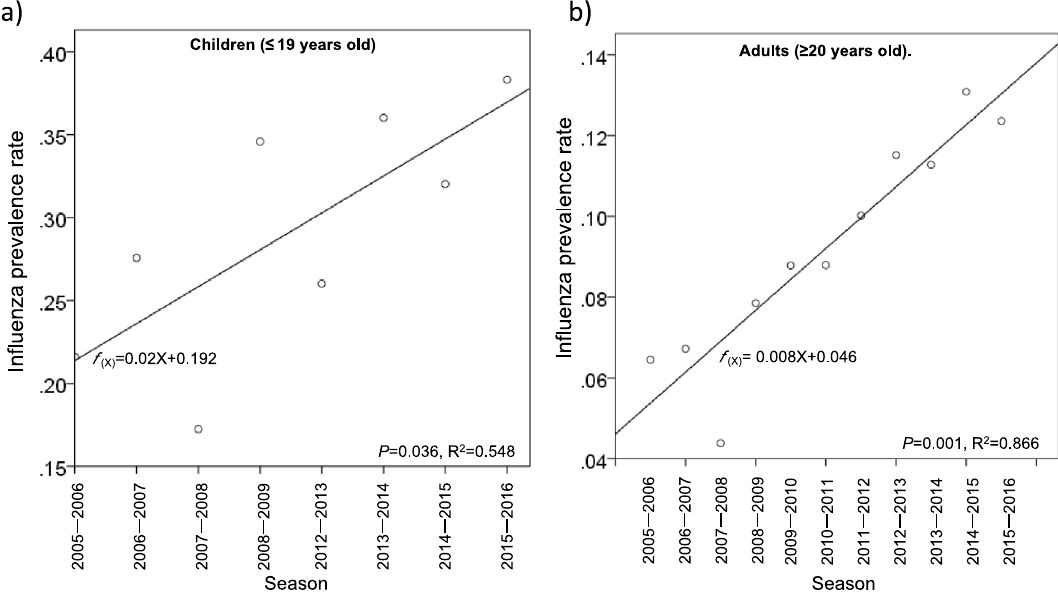
Figure 2. Linear regression model for seasonal influenza prevalence rate. A single linear regression model for the seasonal influenza prevalence rate in ( a ) children (≤ 19 years old) and ( b ) adults (≥ 20 years old). f(x) represents the prevalence rate, and X represents the number of seasons after the 2004–2005 season. For children, the seasons in which A(H1N1)pdm09 emerged (between the 2009–2010 and 2011–2012 seasons) were excluded from the regression